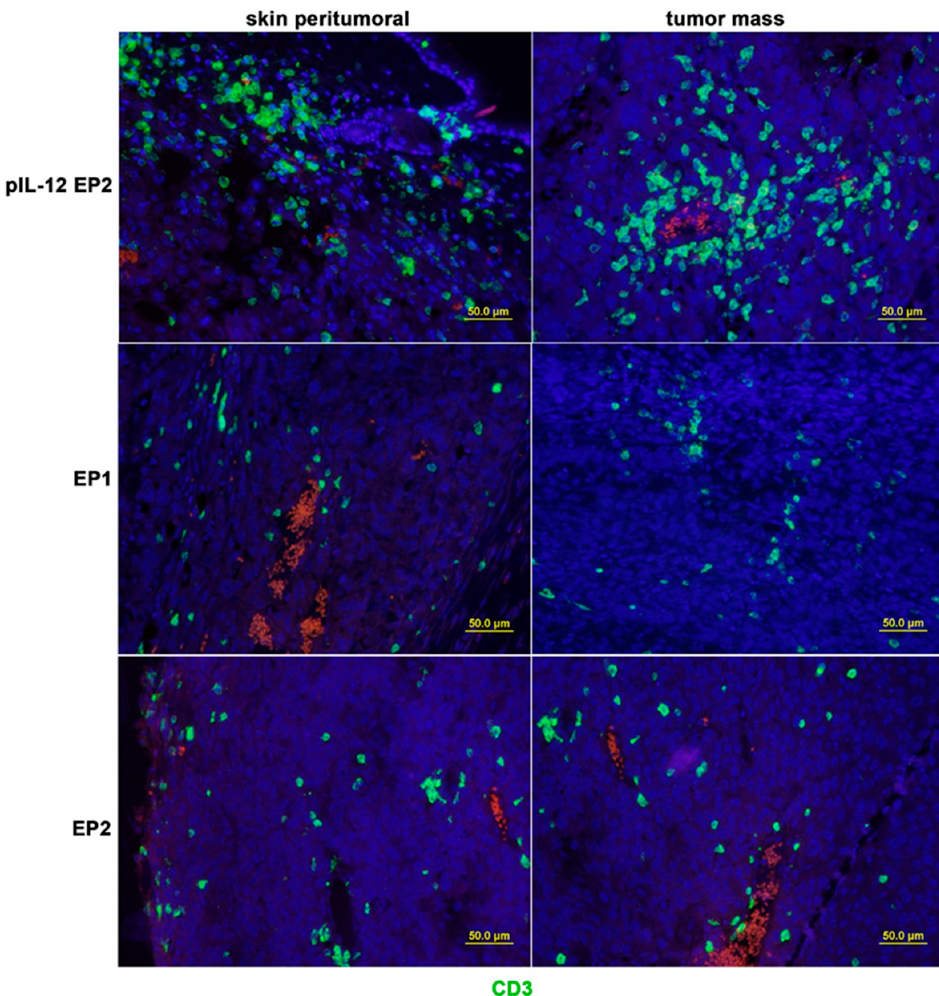
Figure 2. pIL-12 GET impacts tumor immune infiltration location. Tumors were collected at day 9 for histological analysis. Paraffin sections of tumor tissue were stained with anti-CD3 (green, Opal 520). Opal 570 (red color) was used to confirm the non-specific staining of anti-CD3. Results are given as the location of CD3 + cells from the different groups. Three mice per group. Visualized by optical microscopy (×200). Red: Opal 570; Green: Opal 520; Blue: 4',6-diamidino-2-phenylindole (DAPI).